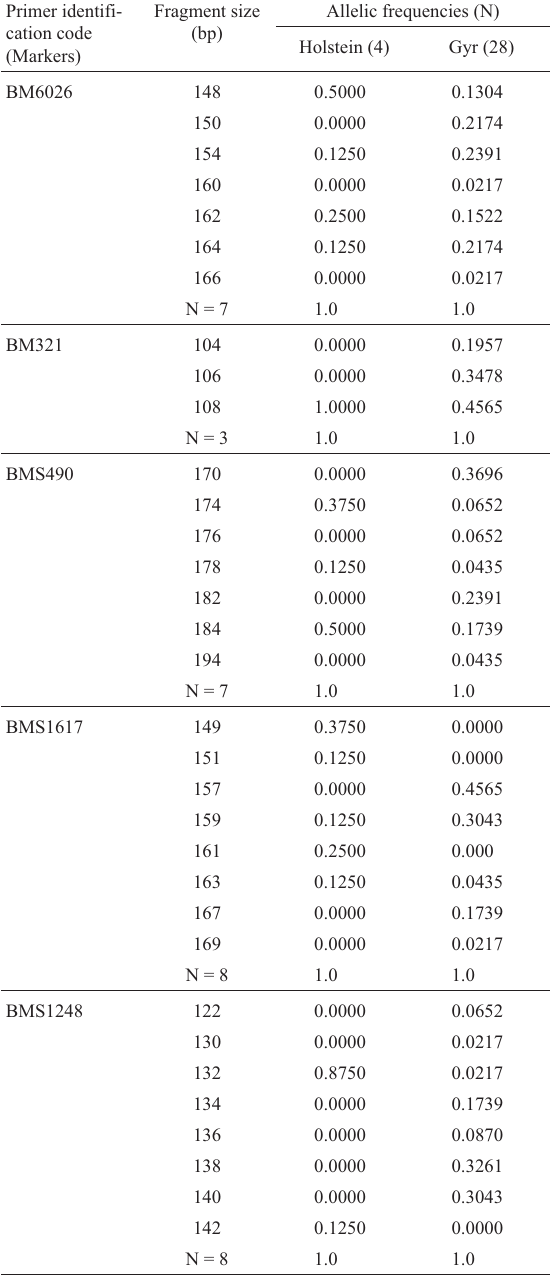
Table 2 - Allelic frequencies for parental generation Holstein and Gyr cattle. Primer identifi- cation code